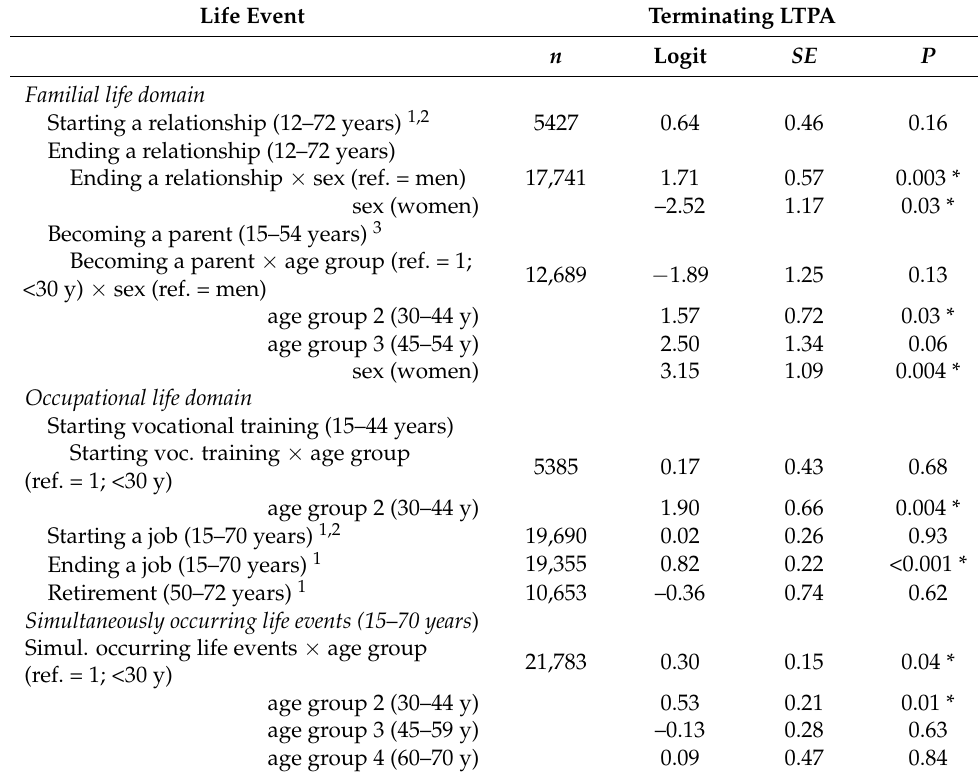
Table 3. Multilevel discrete-time event history analysis with separate calculations for each life event and terminating leisure-time physical activity, controlled for sex, level of education, previous activity duration, quotient active years, and age group (for each complete model, see Supplementary